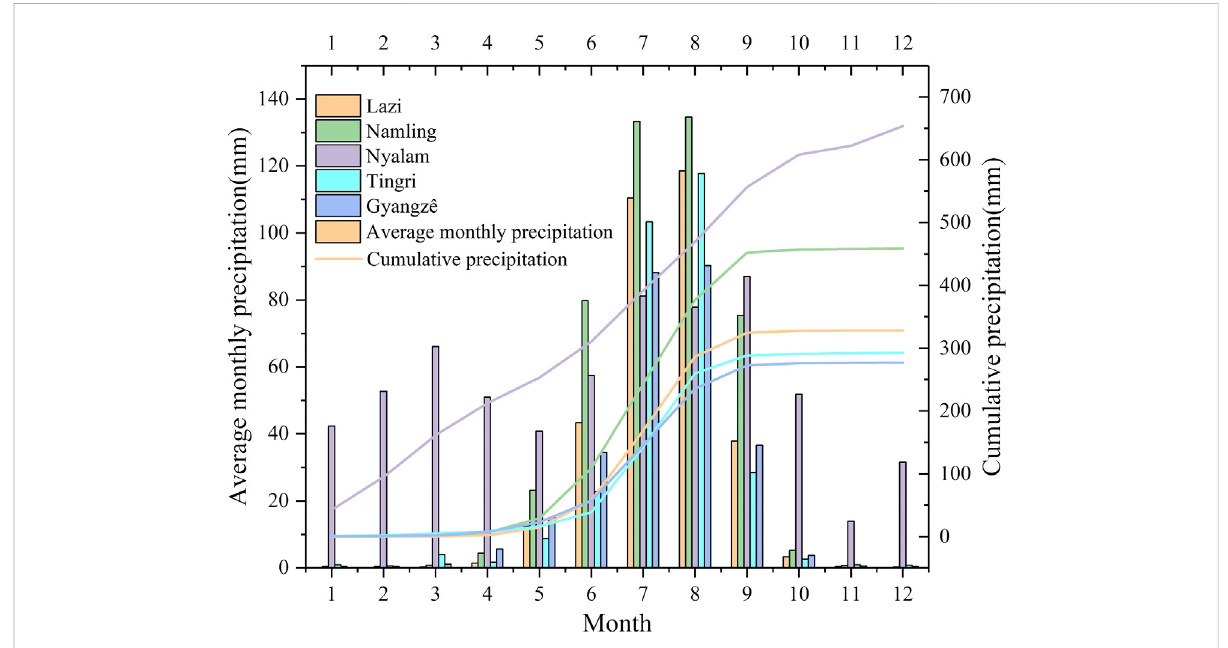
FIGURE 2 Monthly average and cumulative rainfall at hydrological stations in